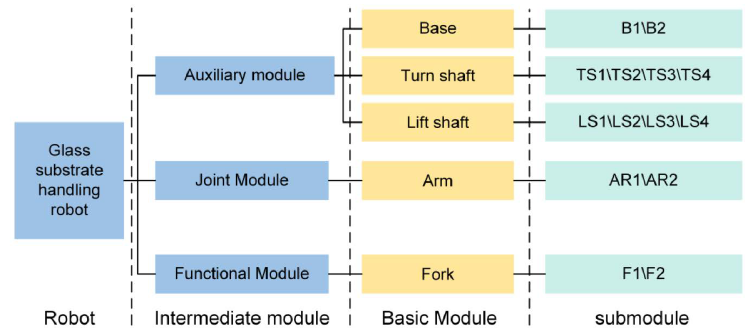
Figure 5. Module division of a glass substrate transfer robot.